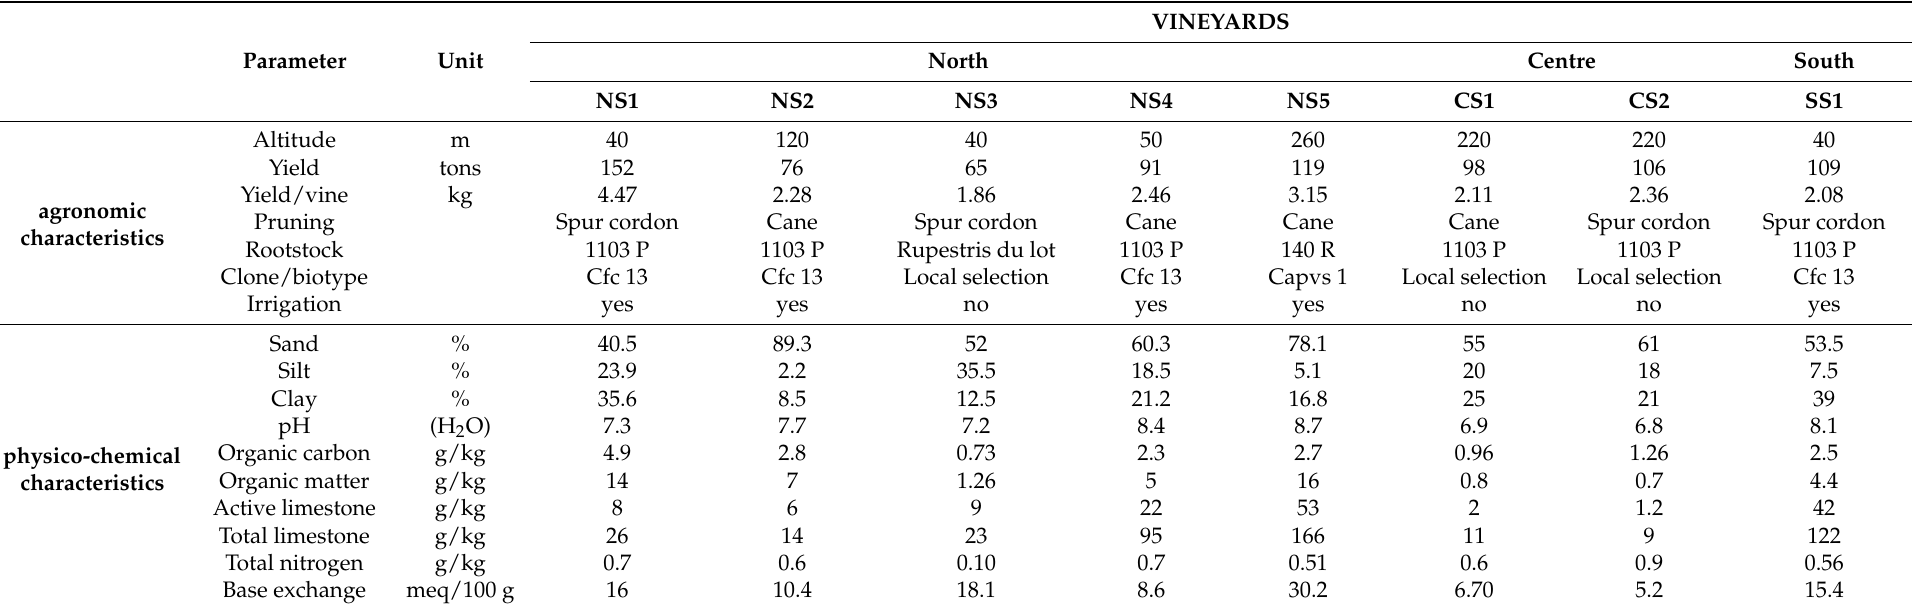
Table 1. Agronomic and physical-chemical characteristics of grapes and vineyards in the different